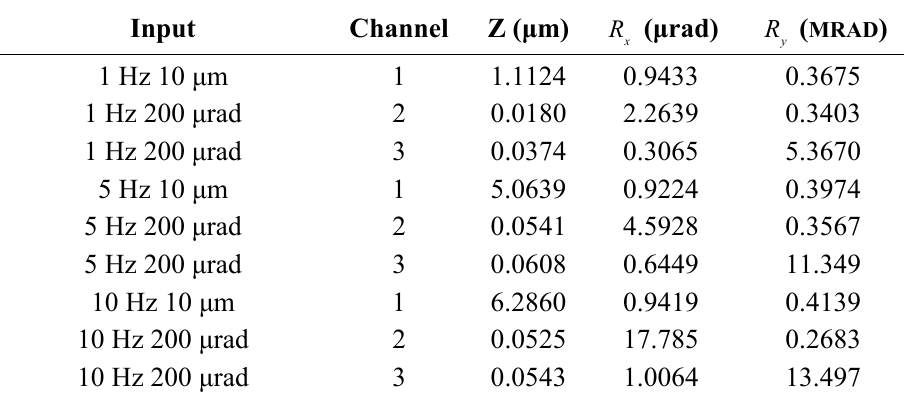
Table 8. Estimation error by applying the identification method introduced in [25].